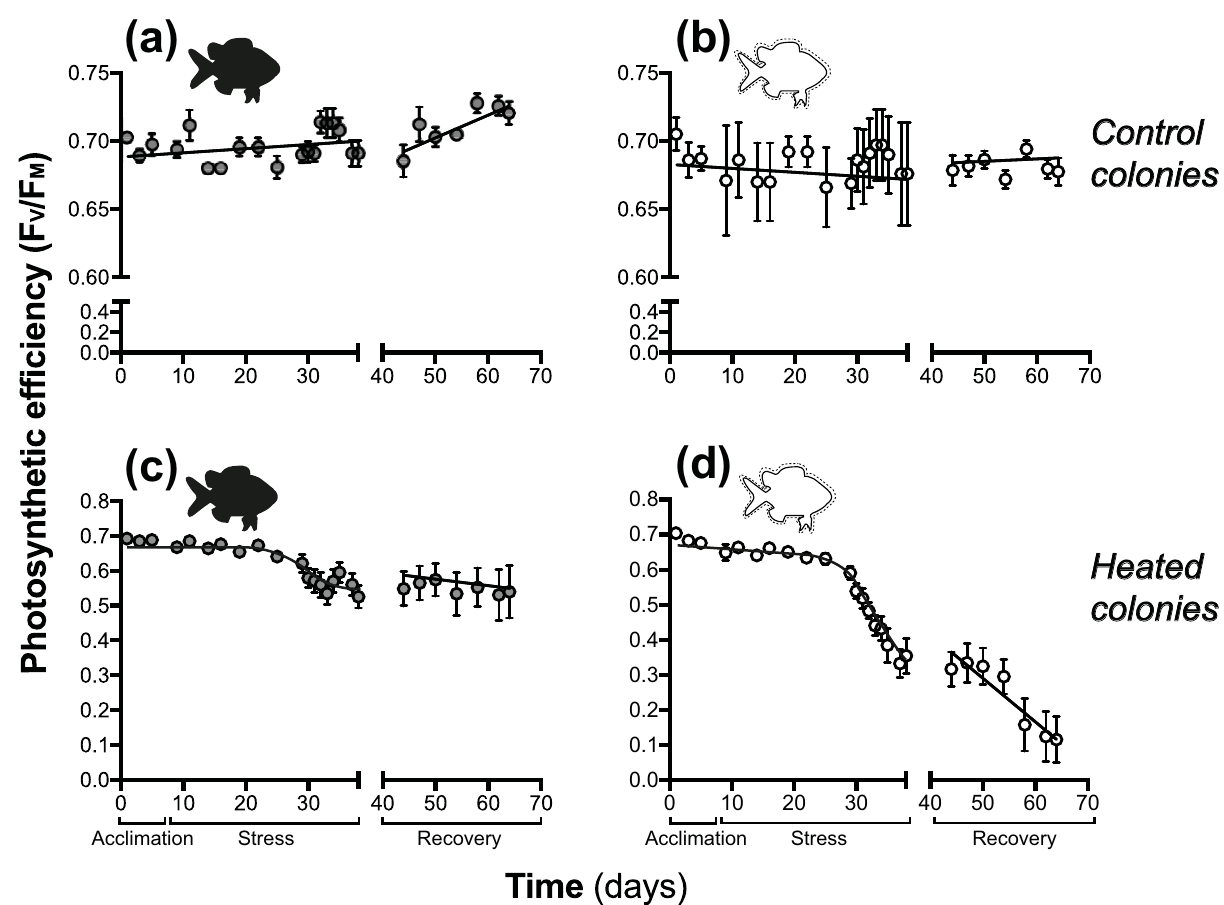
Fig 4. Temporal changes in photosynthetic efficiency (F V /F M ) of P . damicornis with ( a and c ) and without D . aruanus ( b and d ) under control ( a and b ) and heated ( c and d ) treatments. Data are presented for all phases of the experiment: Acclimation (days 1–7), Temperature Stress (days 8–37) and Recovery (days 38–66); and points and error bars show means and S.E. for n = 9 colonies per treatment group. Solid lines show best fit regression lines (for line equations regression coefficients see Table 3). Black fish symbols represent colonies with fish, and white symbols represent colonies without fish. Note different y-axis ranges were used for visual clarity of effects.